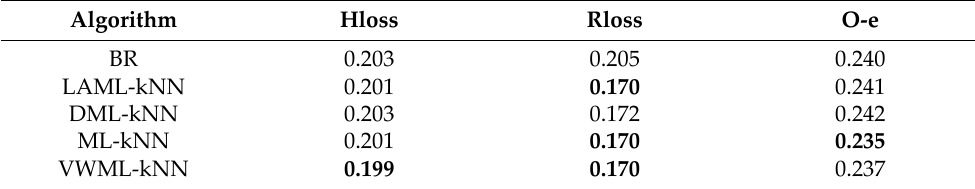
Table 4. Experimental results from different multilabel classification methods on the yeast